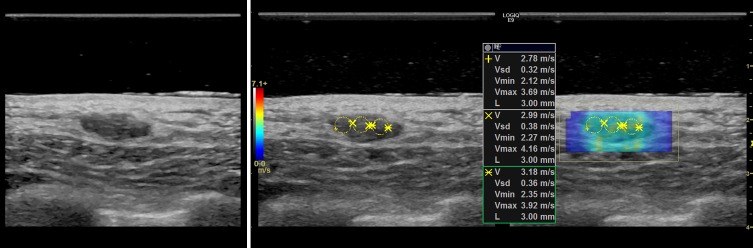
Shear wave speed map of a benign breast mass diagnosed as fibroadenoma.Emean = 26.7kPa.